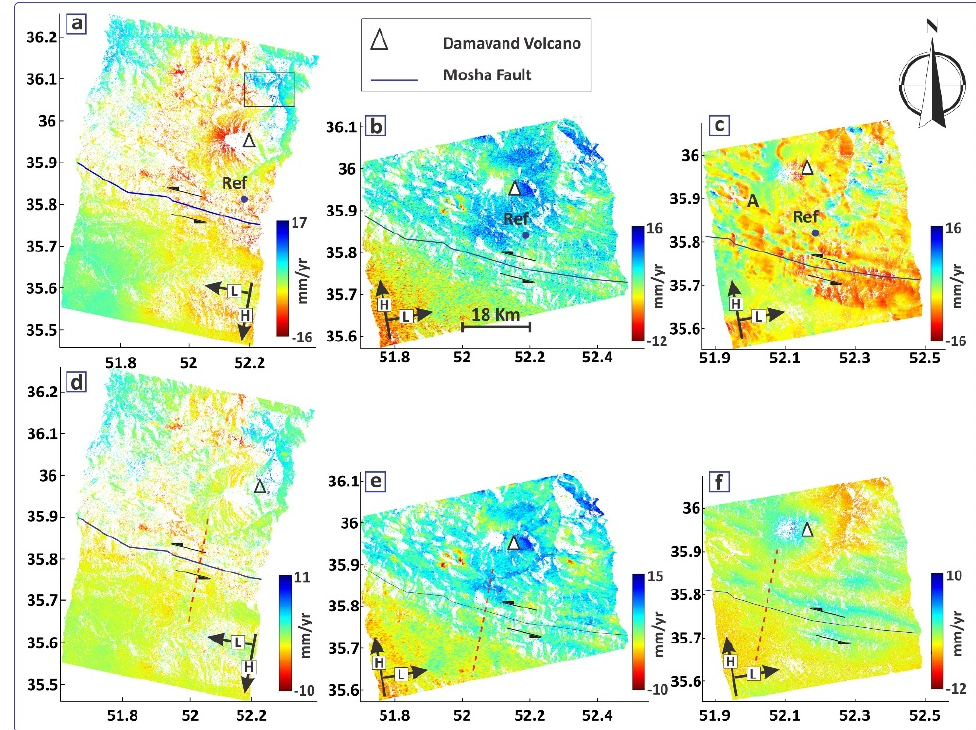
Figure 6. Deformation velocity map obtained from StaMPS for ( a ) Envisat descending ( b ) Envisat ascending and ( c ) ALOS. The location of the Damavand volcano is depicted by a black triangle. ( d ), ( e ) and ( f ) represent the ISBAS final results from Envisat descending, Envisat ascending and ALOS ascending dataset, respectively. Thick black arrows illustrate directions of the satellite track (H) and LOS vector (L). The Mosha fault is indicated by a dashed black line. The reference point, near PLOR station, is depicted by a black circle in (a), (b) and